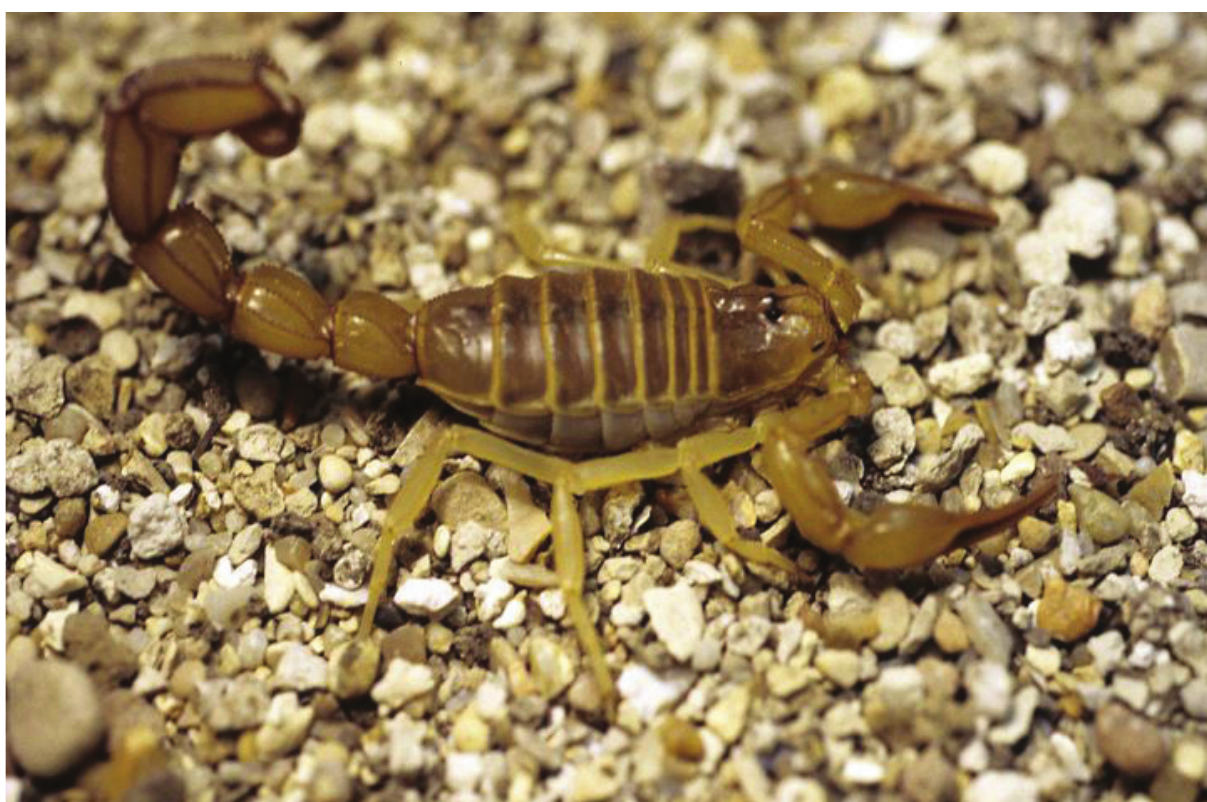
Figure 4. Androctonus amoreuxi , classically described as a non-dangerous scorpion species. In the desert regions of northeastern Mali, it appears to be